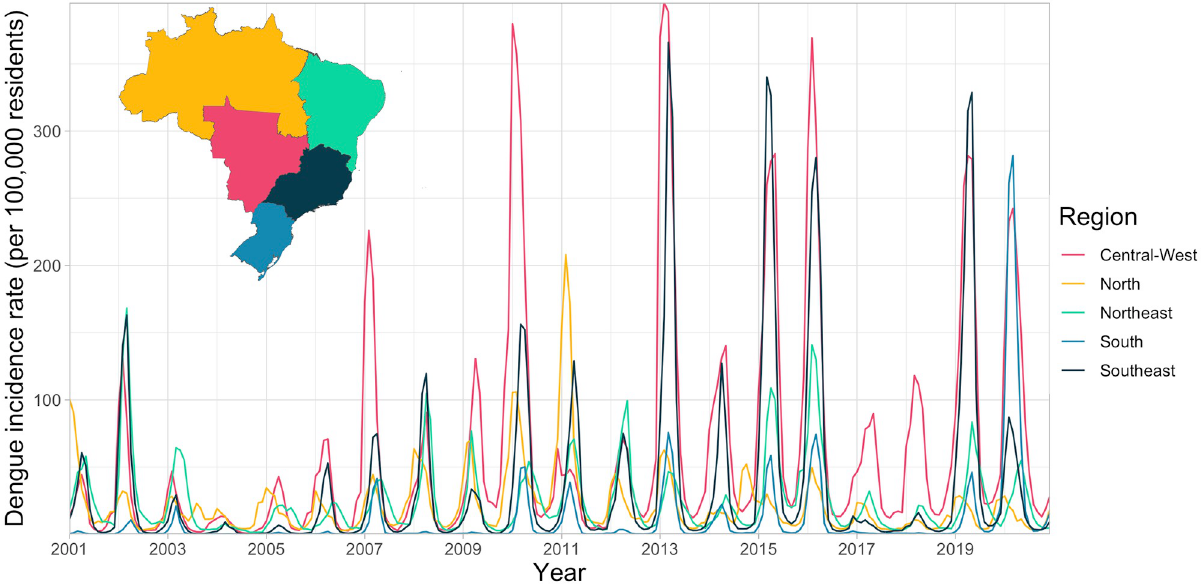
Fig 3. Monthly incidence rate per 100,000 residents in regions of Brazil 2001–2020. Incidence rates have increased in every region of the country between 2001–2020. The first regional outbreak occurred in 2010, outbreaks have occurred more frequently and in more regions since then. Maps were produced in R using the geobr package [32,35](https://ipeagit.github.io/geobr/).